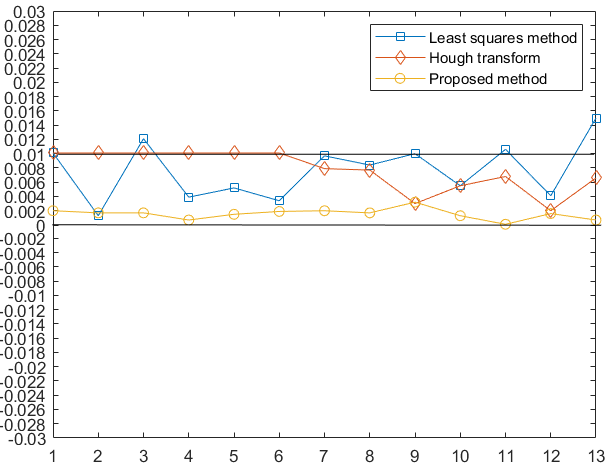
Figure 5. The diameter error curve of 145 type of punched steel strip. To evaluate the accuracy of the fit, we used diameter absolute error, mean diameter round deviation AD ( r ) and diameter deviation variance MSE ( r ) for fitted round holes and exact round holes.